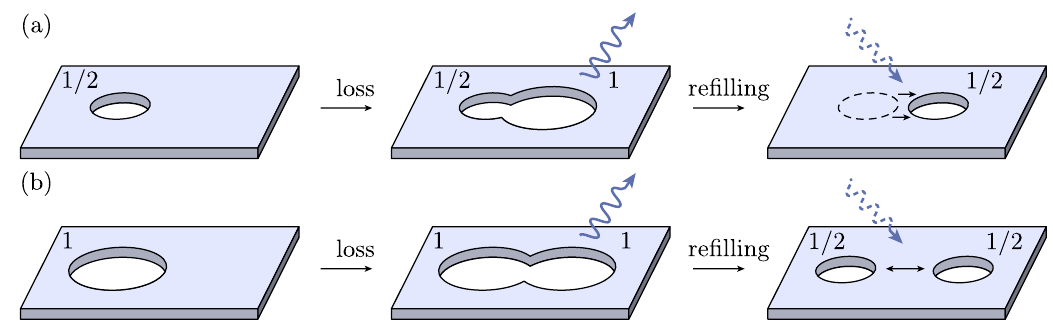
Figure 2: Dissipative dynamics of quasiholes in the stabilized photonic Laughlin state at half-filling. (a) Diffusion of a single quasihole. A photon is first lost in the vicinity of the quasihole and then quickly refilled by the stabilization setup at a different location. As a result the position of the quasihole is shifted in a random direction. (b) A full hole breaks into two stable quasiholes. Again, this requires loss of an additional photon in the vicinity of the initial hole that is followed by a subsequent refilling at a different